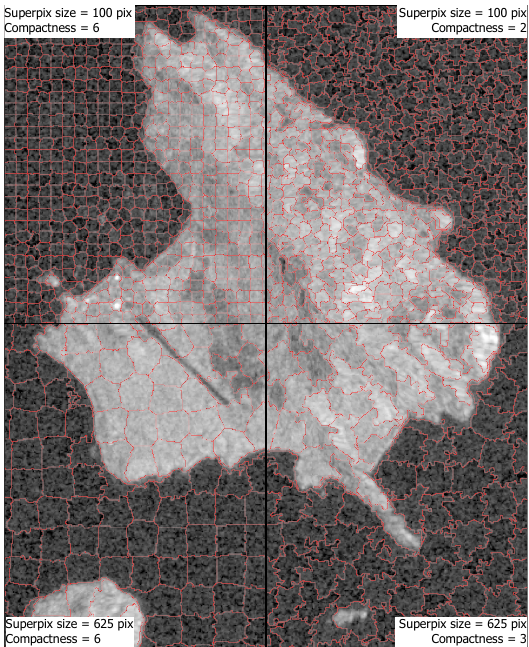
Figure 1. SLIC results comparison with different parameters. The original data is a mediated stack of 5 Sentinel-1 VH band acquired over the Lizard island,